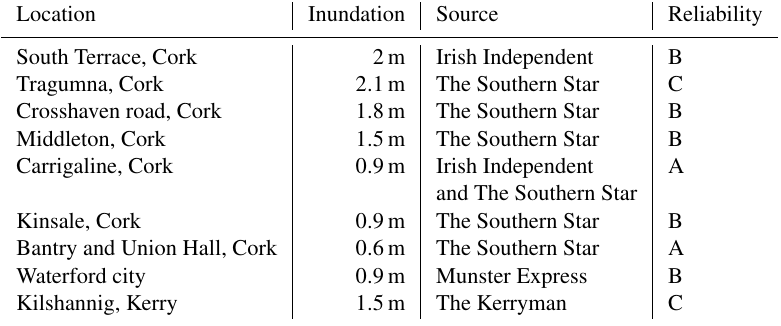
Table 4. Coastal flooding in excess of 0 . 5m on 7 March 1962. The reliability of sources are labelled from “A” to “C”: where “A” indicates an official technical report, “B” indicates a report in a newspaper article, and “C” is an eyewitness account in a newspaper article. Location Inundation Source Reliability South Terrace, Cork 2m Irish Independent B Tragumna, Cork 2 . 1m The Southern Star C Crosshaven road, Cork 1 . 8m The Southern Star B Middleton, Cork 1 . 5m The Southern